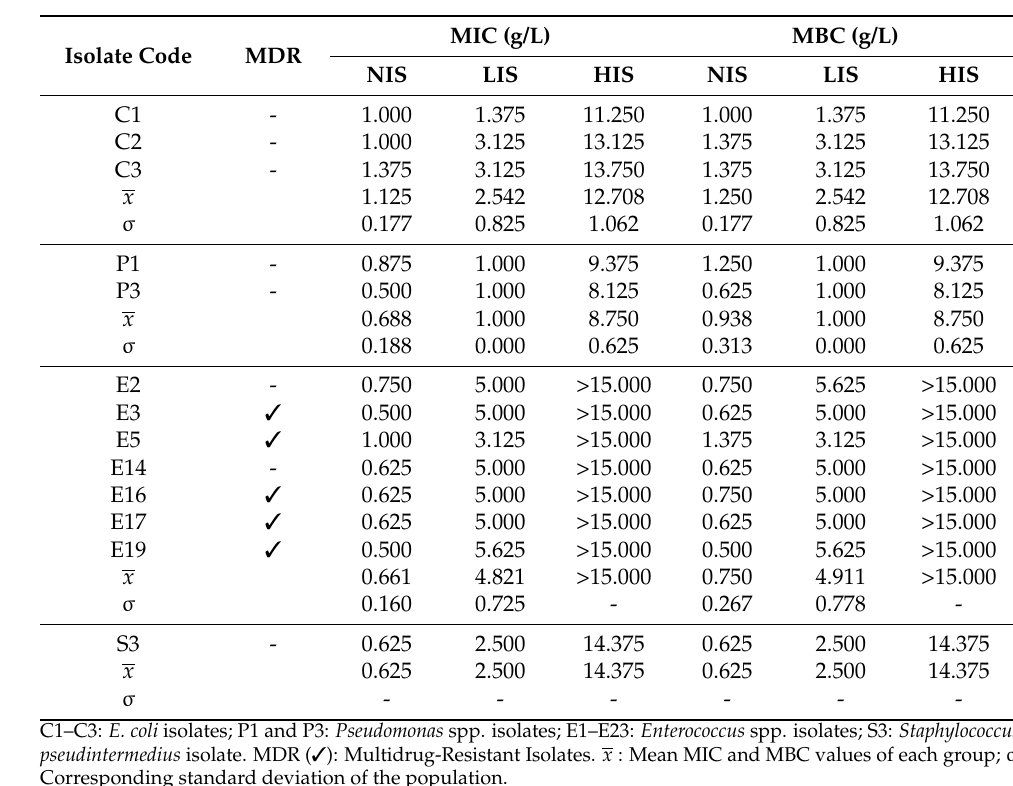
Table 2. Virkon™ S’s mean MICs and MBCs values towards all isolates tested, divided between assays with no interfering substance (NIS), low interfering substance (LIS), and high interfering substance (HIS) (grams per liter, g/L).